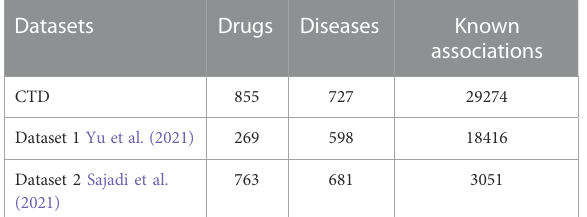
TABLE 1 The statistics of three